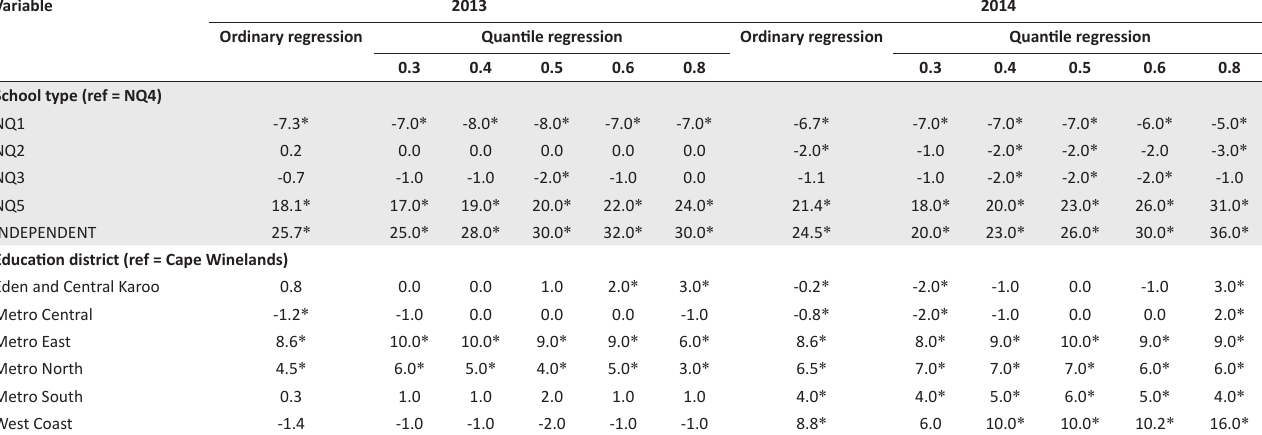
NQ, national quintile. * , denotes statistical significance at 5 % .